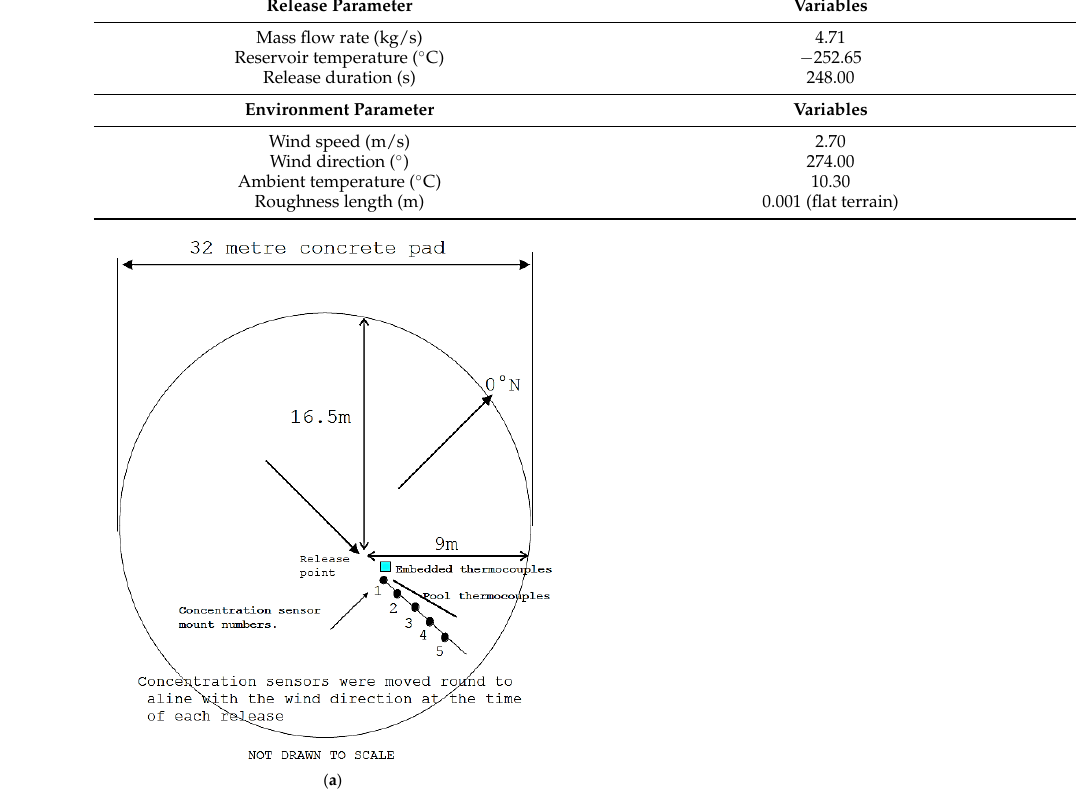
Table 8. Parameters for LH release test [57].